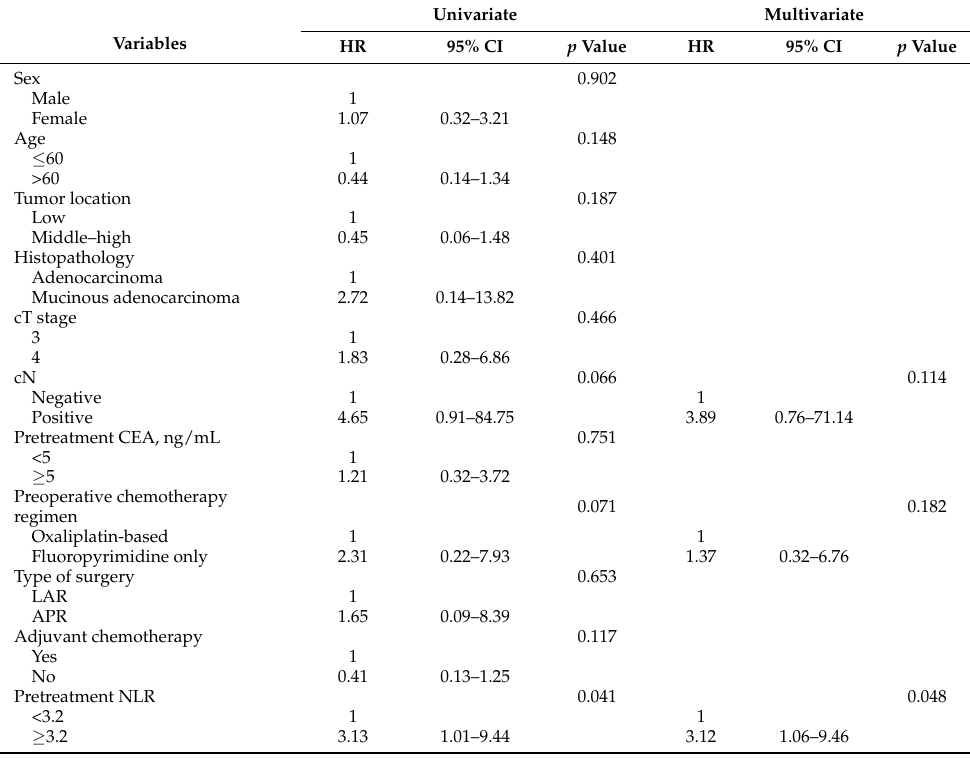
Table 3. Univariate and multivariate analysis for disease-free